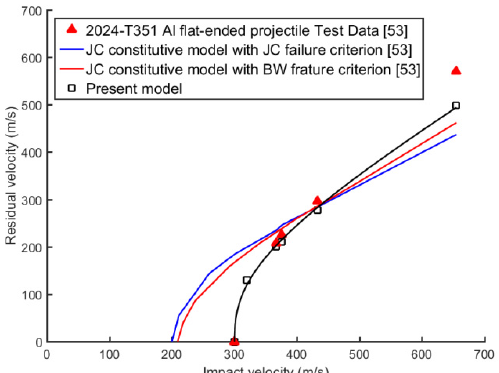
Figure 22. Comparison of the numerically predicted residual velocities with the test results for the perforation of the 4-mm-thick 2024-T351 aluminum alloy plates struck normally by the 5.5-mm-diameter flat-ended projectile.